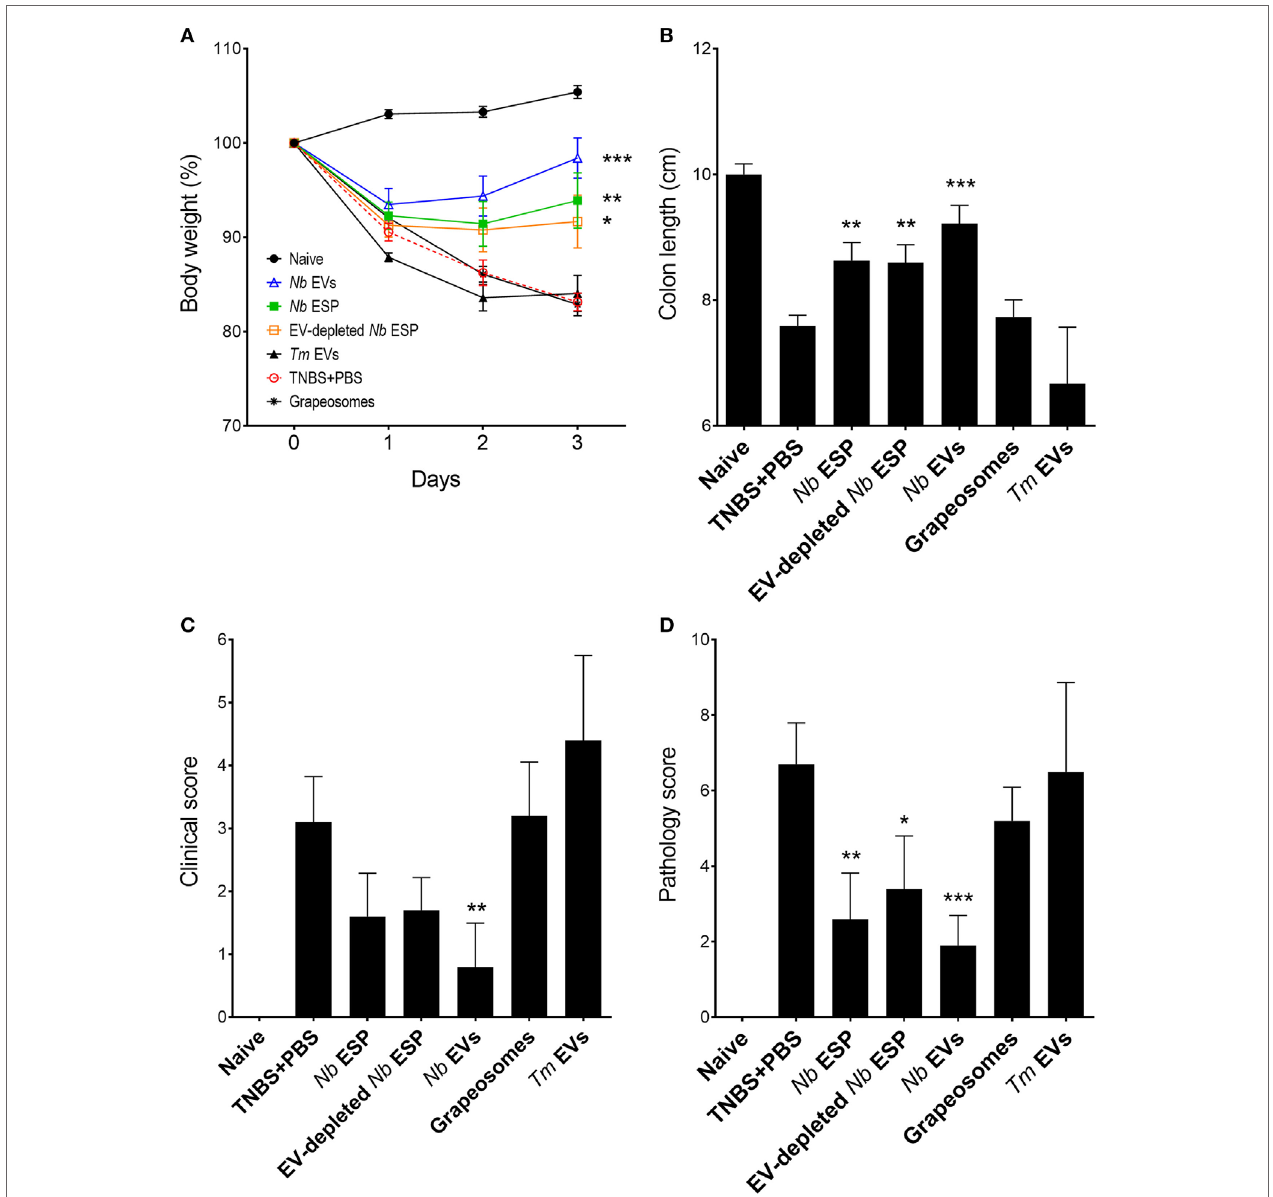
FigUre 3 | Protective effects of Nippostrongylus brasiliensis secreted fractions in experimental colitis. Mice received a single intraperitoneal injection of 20 µg protein in PBS 1 day prior to intrarectal administration of 2.5 mg of TNBS in 50% ethanol. (a) Body weight was recorded daily for the indicated groups. (B) Colon length measured after euthanasia at the end of the experiment (day 3). (c) Clinical examination and scoring of mice on day 3, including weight loss, piloerection, feces consistency, and mobility of mice from normal to severely affected (0–3). (D) After euthanasia, colons were visually scored by presence of adhesions, edema, mucosal wall thickening, and ulceration from absent to severe (high) on a scale of 0–3. Data show mean ± SEM of pooled data from two independent trials ( n = 10 mice/group). Groups were compared to the PBS + TNBS (colitis) control group by Mann–Whitney U -test. * p < 0.05; ** p < 0.01; *** p < 0.001. Data for Trichuris muris ( Tm ) extracellular vesicles (EVs) were analyzed in a separate independent experiment (see Figure S1 in Supplementary Material) and included only for